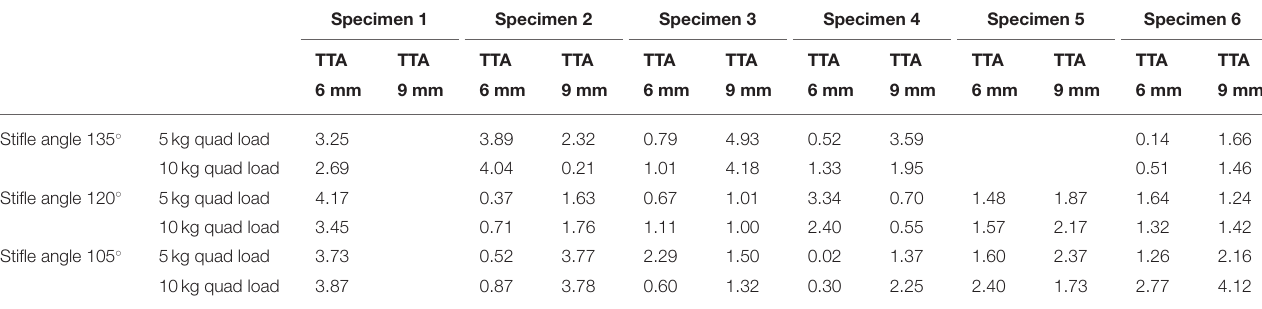
TABLE 2 | Absolute translation (mm) of the tibia relative to the femur at the load prior to failure listed in Table 1